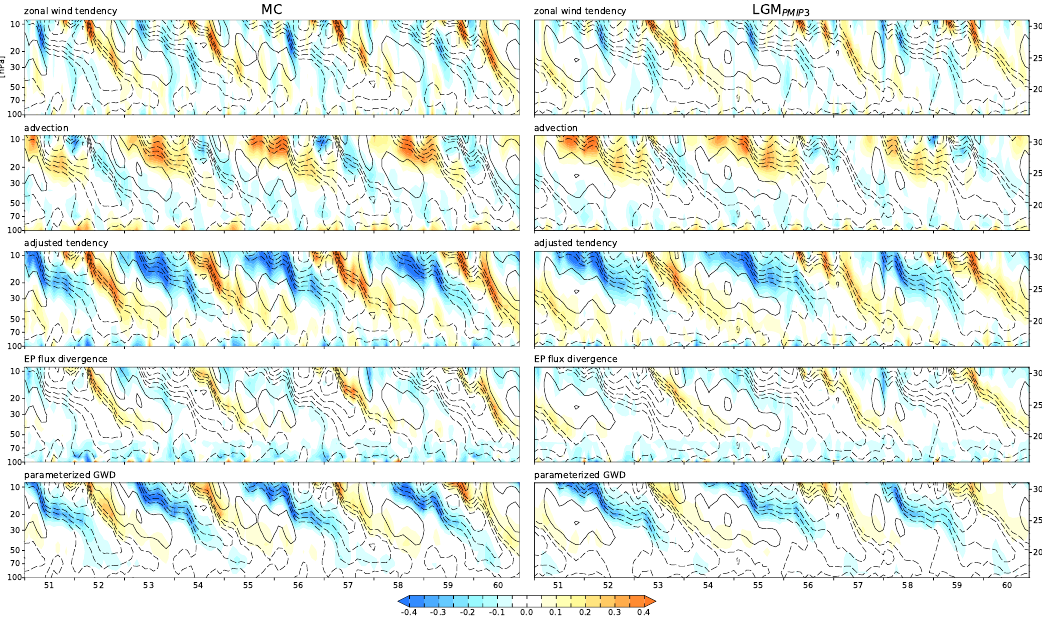
Figure 4. Time-height sections of the zonal-mean zonal wind tendency and the contribution from di ff erent zonal-mean zonal momentum budget terms (colored shading), including advection, Eliassen-Palm (EP) flux divergence, and parameterized gravity wave drag (GWD) for the simulations of (left) modern climate (MC) and (right) Last Glacial maximum with the PMIP3-simulated SST (LGM PMIP3 ). The adjusted tendency is the zonal wind tendency minus advection. The zonal-mean zonal wind are shown in contours with an interval of 5 m s − 1 (westerlies are solid, easterlies dashed, and zero contour omitted). The results are based on daily data, smoothed by a 30-day running mean and averaged over 5 ◦ N /